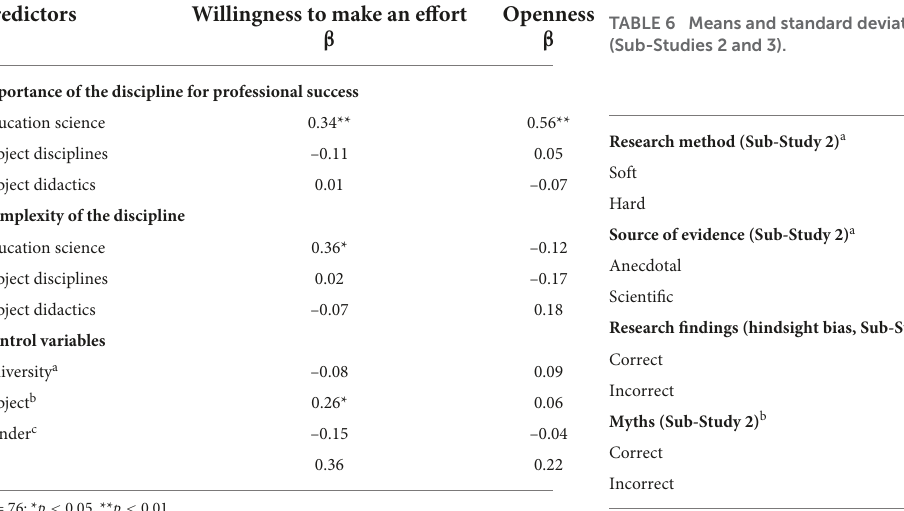
TABLE 5 Results of the regression analysis predicting engagement with education science (Sub-Study